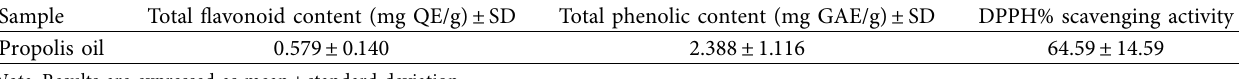
Table 1: Total phenolic content, total flavonoid content, and DPPH scavenging activity of propolis oil.